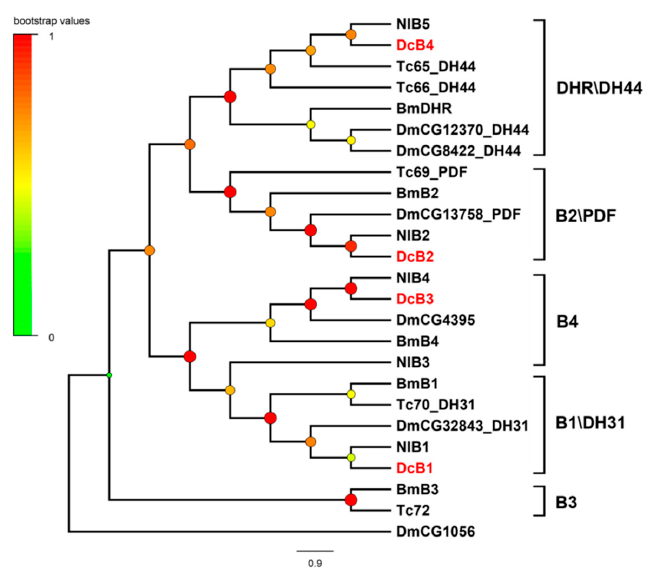
Figure 3. Phylogenetic tree of the B-family neuropeptide GPCRs. The neighbor-joining trees were constructed using MEGA 6 software with 1000-fold bootstrap repetitions. The B-family neuropeptide GPCRs of D. citri are shown in red text. Dc, D. citri ; Dm, D. melanogaster ; Nl, N. lugens ; Bm, B. mori ; Tc, T. castaneum . Int. J. Mol. Sci. 2018 , 19 , x FOR PEER REVIEW